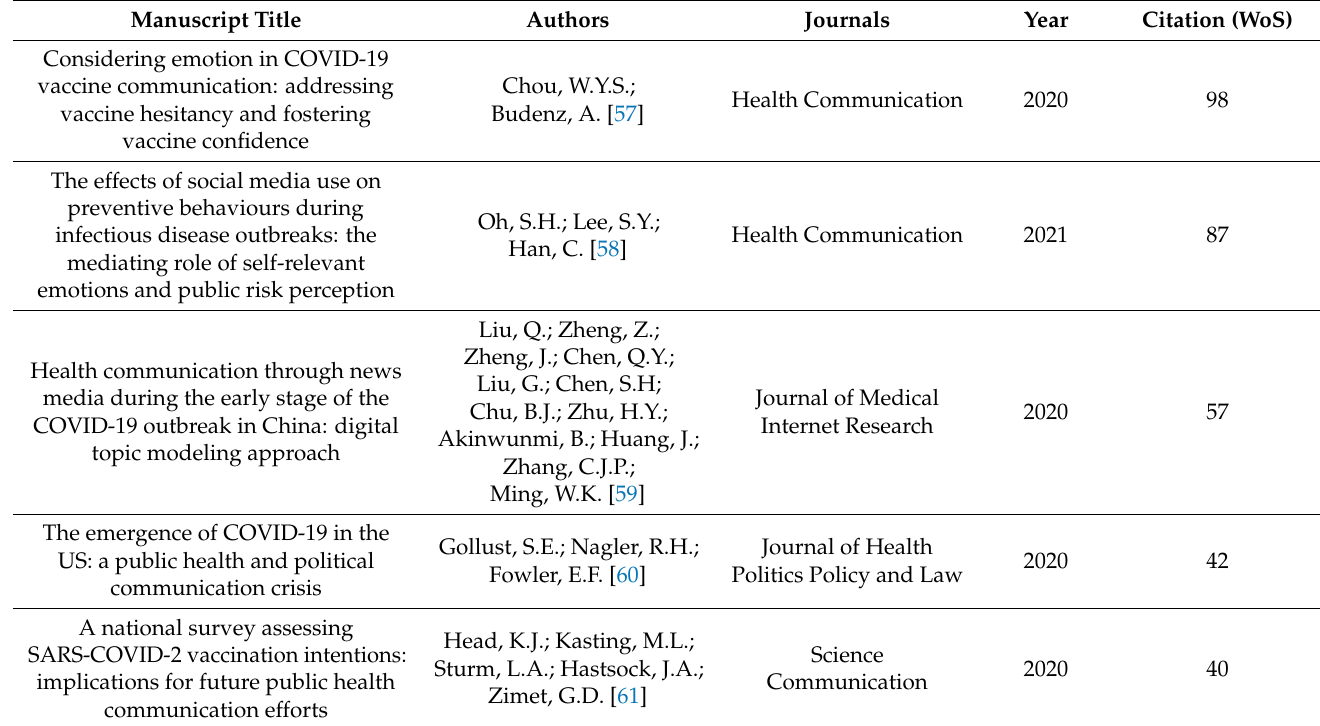
Table 9. Articles with the highest citation index on COVID-19 and health